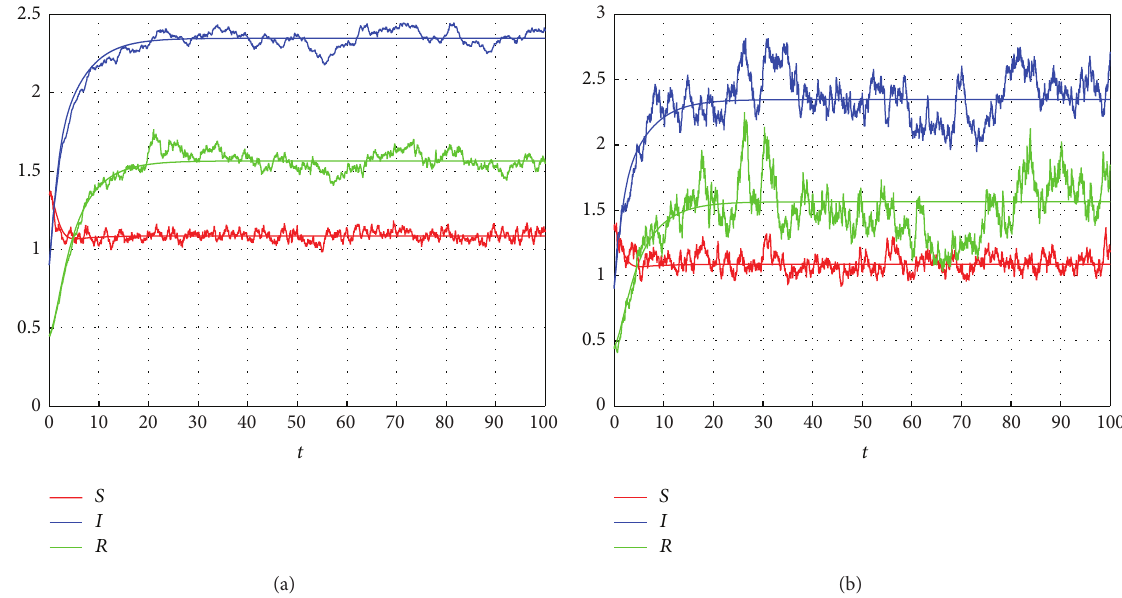
Figure 1: Solutions of model (3) with different noise. Other parameters and initial condition are given in text. (a) 𝜎 1 = 0.05 , 𝜎 2 = 0.01 , and = 0.03 and (b) 𝜎 = 0.1 , 𝜎 = 0.06 , and 𝜎 = 0.12 𝜎 3 1 2 3